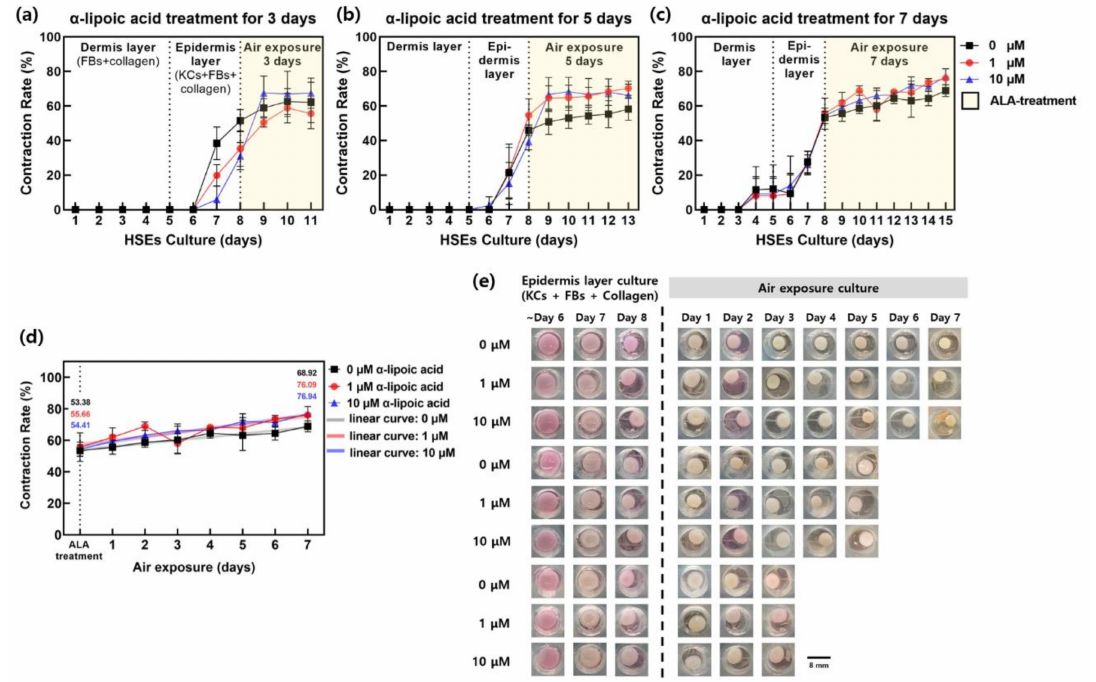
Figure 1. Variation of the contraction rate of the samples as a function of the air exposure 3, 5, and 7 days with the different concentrations (0, 1, 10 µ M) of α -lipoic acid. The graph is the contraction rate of the group treated with α -lipoic acid for ( a ) 3 days, ( b ) 5 days, and ( c ) 7 days under air exposure culture conditions. The legends in the graphs ( a – c ) are the same. ( (cid:4) , 0 µ M α -lipoic acid; • , 1 µ M α -lipoic acid; and (cid:78) , 10 µ M α -lipoic acid) ( d ) It is a graph comparing only the contraction rate of the 8th day, which is the period of coculture to dermis and epidermis, and the air exposure period of which α -lipoic acid was treated (maximum processing period for α -lipoic acid is 7 days). The change was represented by a linear curve during the α -lipoic acid processing period. ( e ) Photographic images of the samples following air exposure for the different concentrations of α -lipoic acid (bar = 8